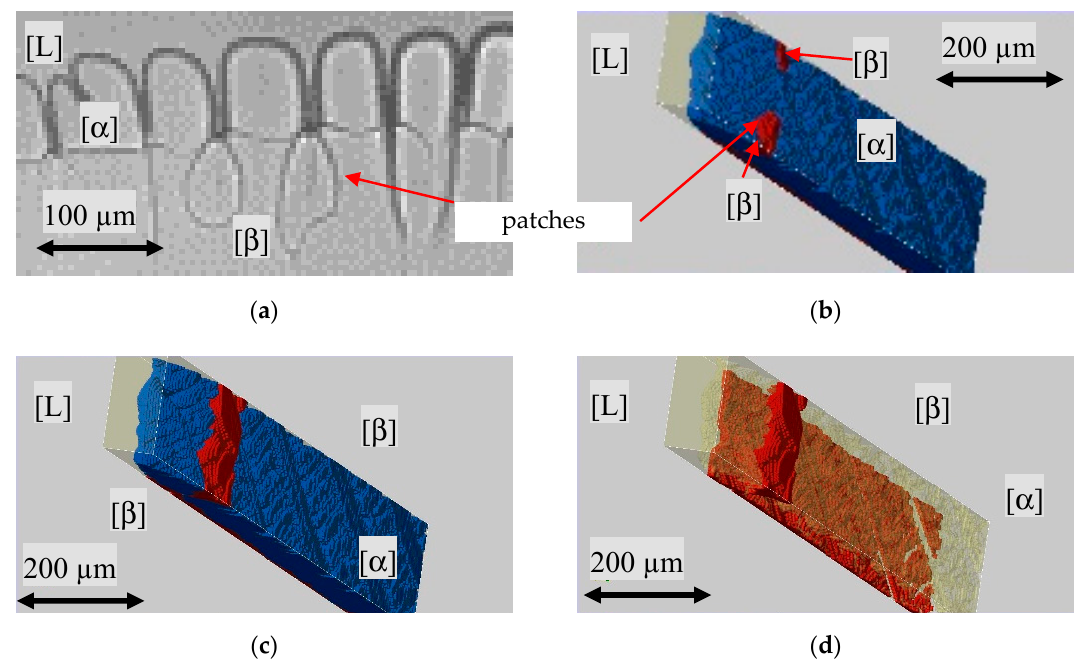
Figure 13. ( a ) The peritectic β -phase appears in the transparent model system with an almost flat s/l interface and some patches. ( b , c ) show that the primary α -phase (blue) is enveloped by the peritectic β -phase (red). ( d ) The coating takes place by the peritectic β -phase (red) growing through the interstitial melt (transparent light yellow) of the primary phase (transparent).